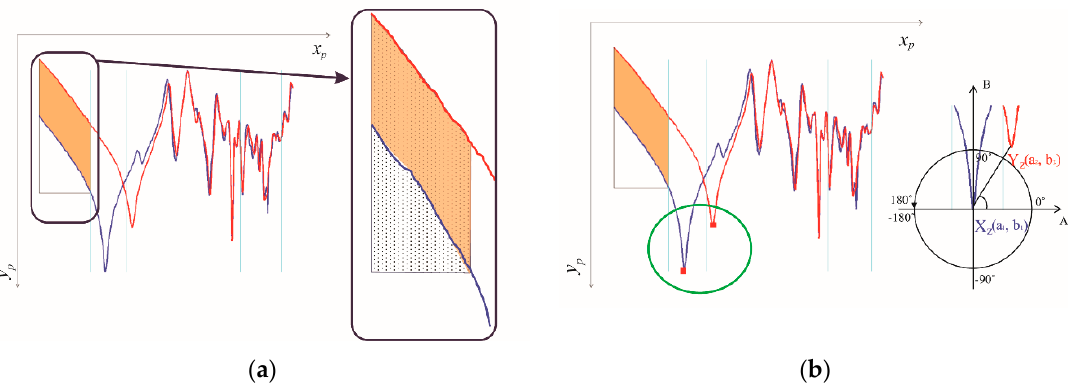
Figure 8. Schematic Explanation of ( a ) the area ratio index (ARI) and ( b ) angle difference (AD) of the anti-resonance in LF2.